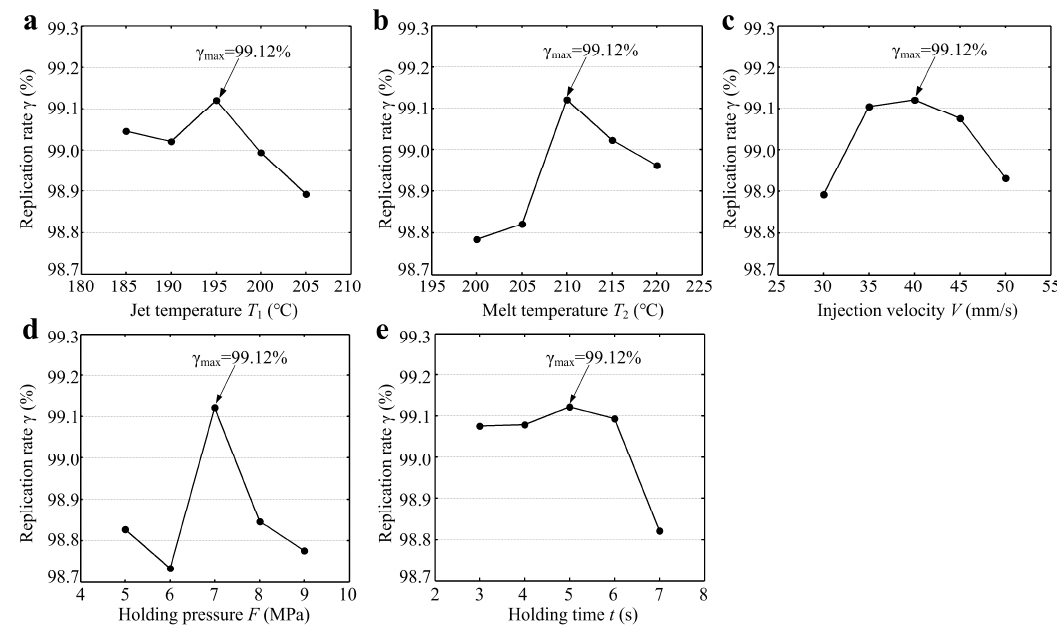
Figure 9. The effects of micro-injection molding parameters on replication rate γ : (a) jet temperature T 1 ; (b) melt temperature T 2 ; (c) injection velocity V ; (d) holding pressure F ; (e) holding time t .